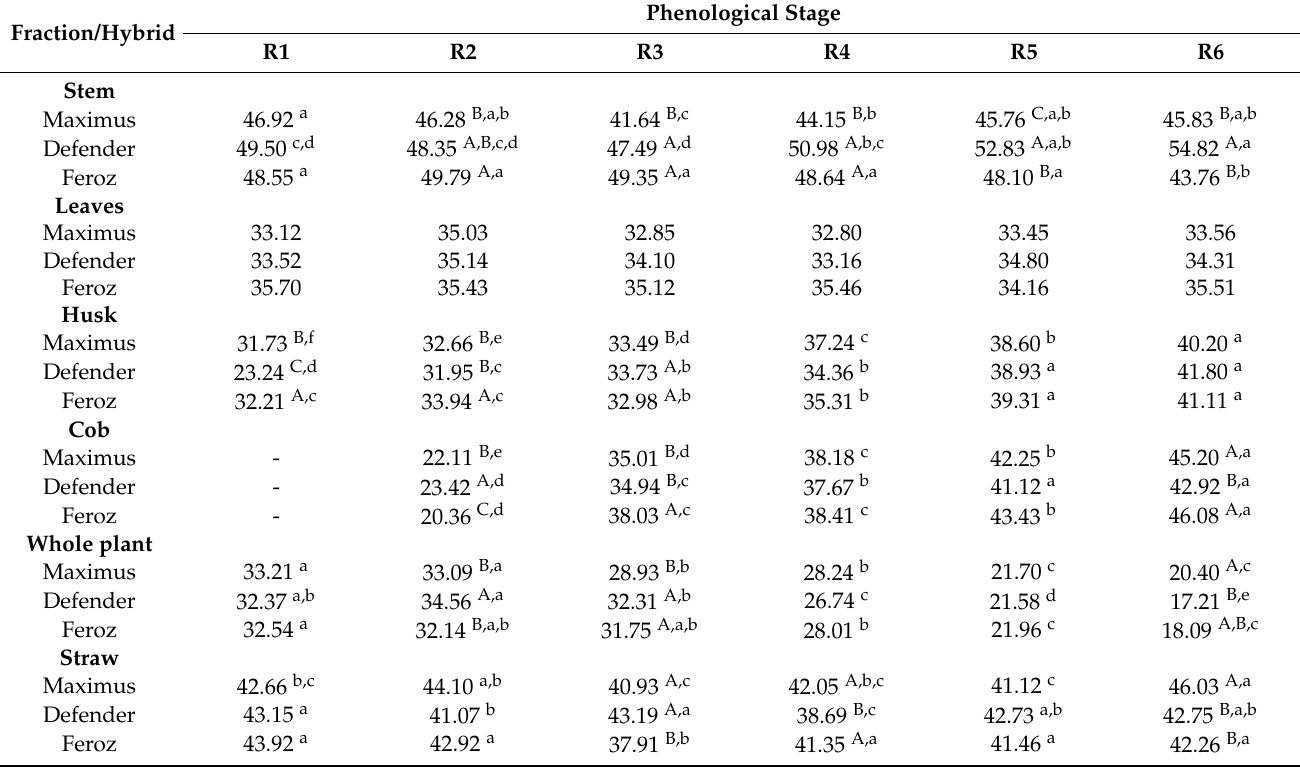
Table 4. Acid detergent fiber (% DM) of the whole plant and the fractions of three maize hybrids harvested at the beginning of the six reproductive stages of